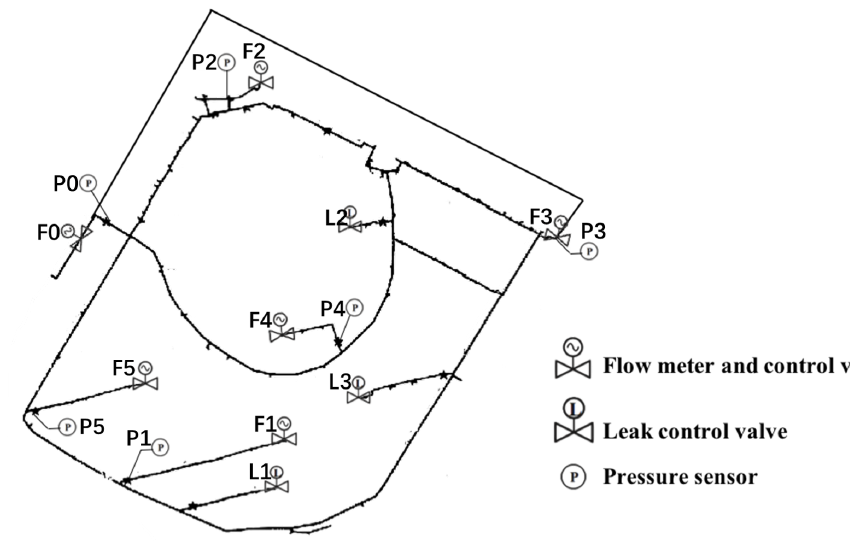
Figure 11. The topology built by experimental platform.